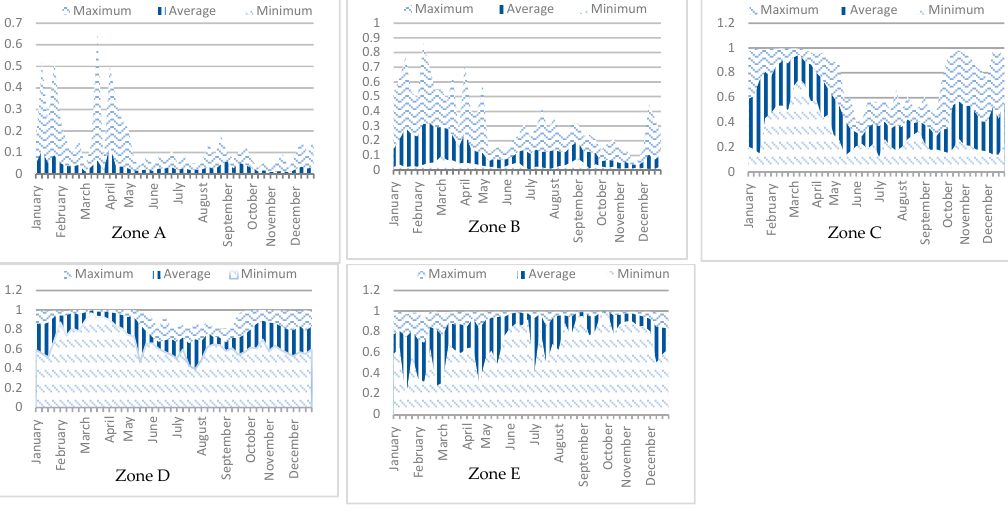
Figure 4. Snow cover fraction (SCF) variation among different zones derived from moderate resolution imaging spectroradiometer (MODIS) eight ‐ day snow cover product MOD10A2 from the year 2005 to 2018.